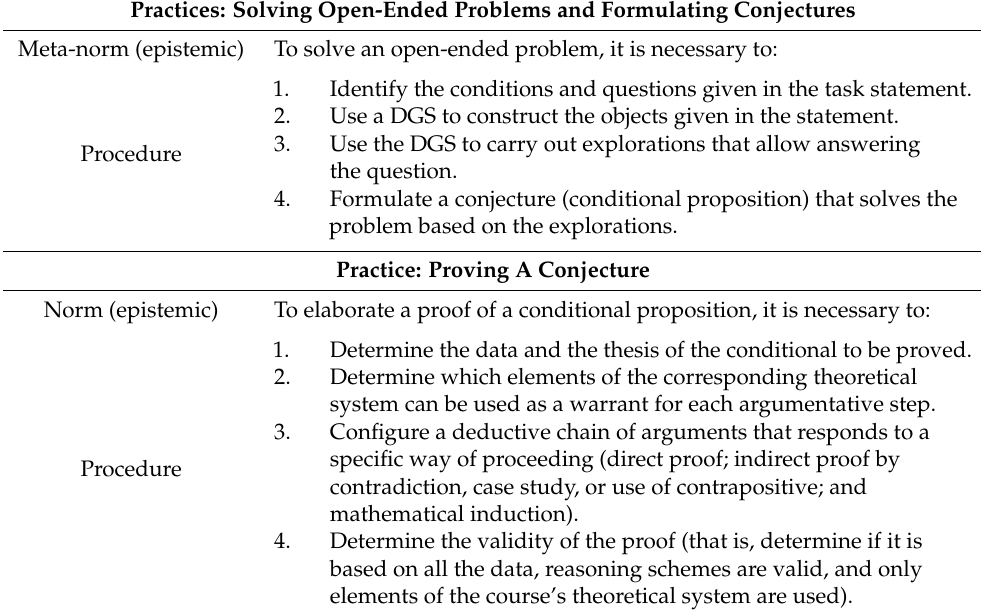
Table 1. Norms and practices of the course related to the theorem-construction process. Practices: Solving Open-Ended Problems and Formulating Conjectures